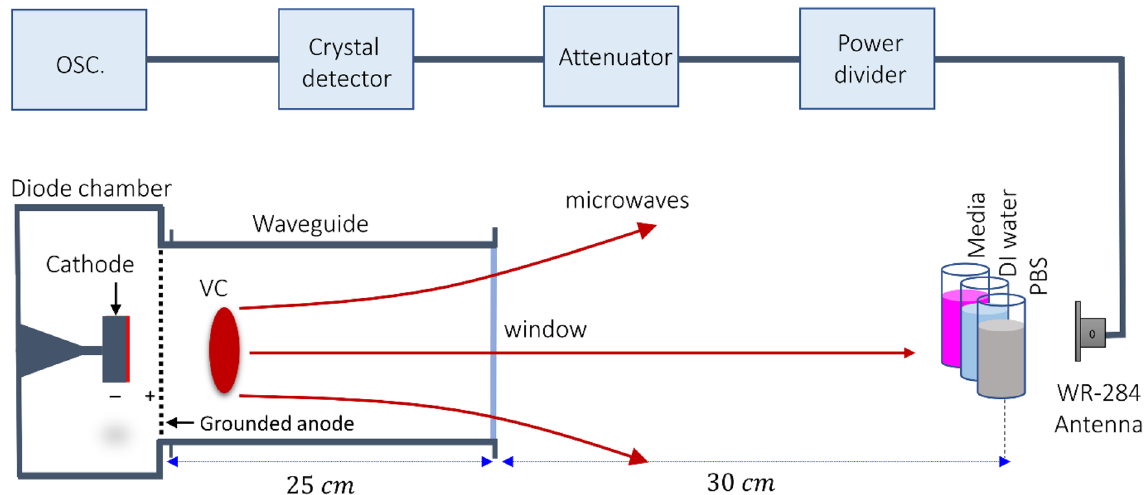
Figure 1. Configuration of the diode region of the HPM generator “Chundoong”. The emitter cathode used for the emission of electron beam. The anode and cathode gap distance was 10 mm and the high power microwaves (HPM) were generated with a frequency of 3.5 GHz from the dense virtual cathode (VC) and propagated outside from the window of the waveguide. The bilological solutions were positioned 30 cm away from the window. The WR-284 is the receiving antenna which is used to measure the power of HPM. The HPM then passes through the power divder to divde the power into two equal amounts, attenuator, and a crystal